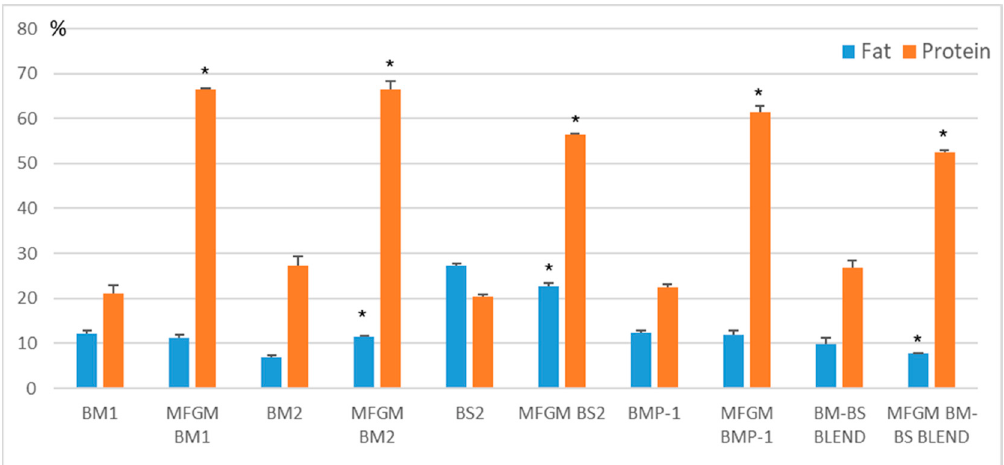
Figure 3. Fat and protein contents expressed as means of the selected samples and their corresponding MFGM isolates (g/100 g of sample ± standard deviation) of at least two replicates. *: in the column between each sample and their corresponding MFGM isolate, indicates significant differences ( p < 0.05).